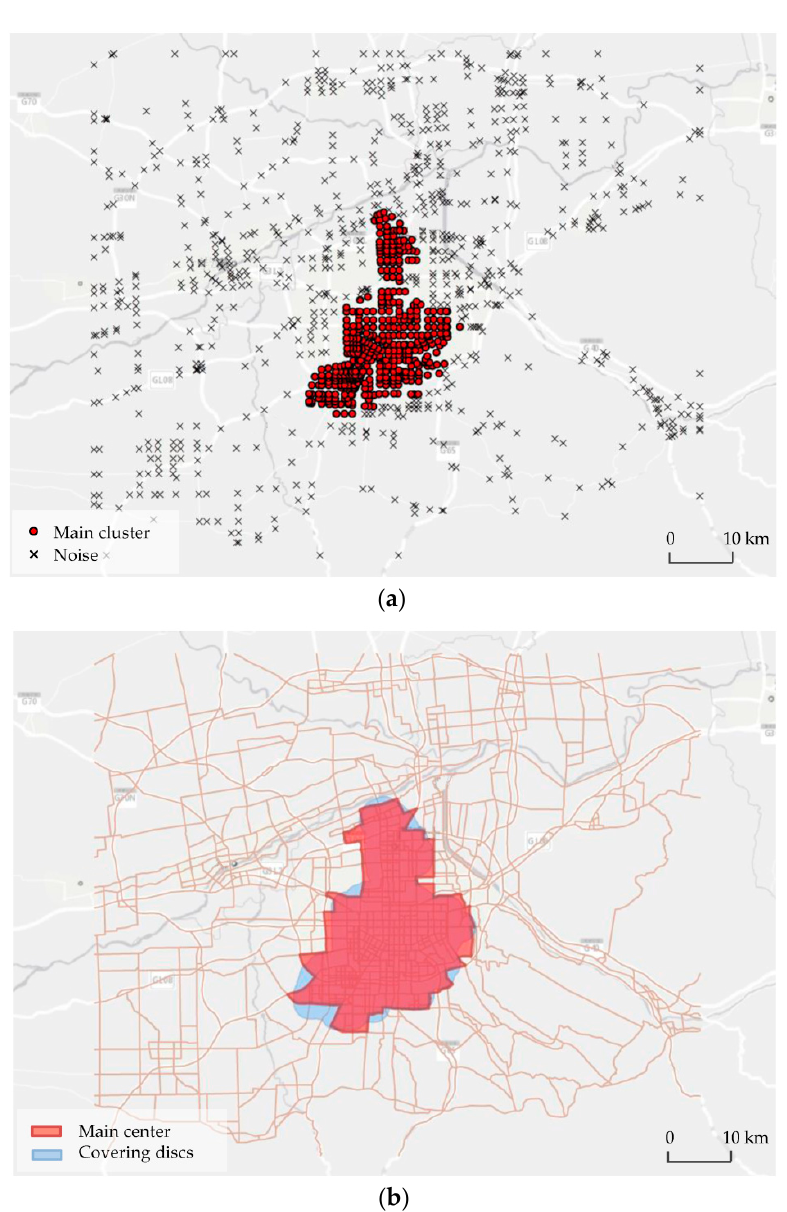
Figure 8. ( a ) Main cluster of the road nodes in Xi’an; ( b ) main center pattern in Xi’an.